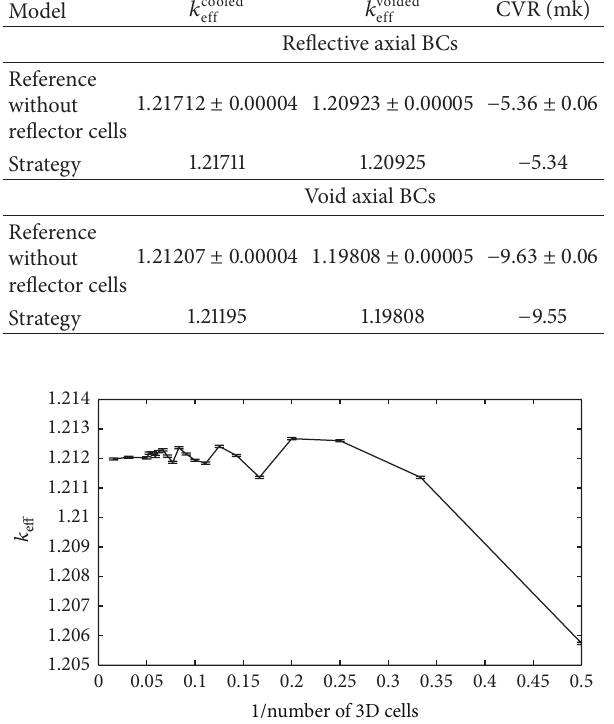
BCs where the neutrons reaching the boundary of cells C1 and C14 are reflected and (2) void axial BCs where the neutrons leaving cells C1 and C14 respectively in the − z and + z directions are lost.